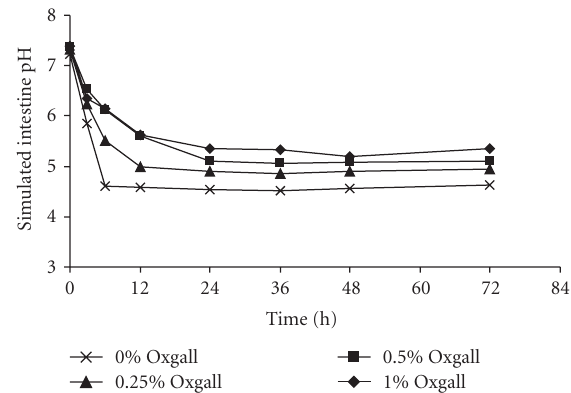
Figure 8: E ff ect of bile concentration on metabolic activity of mi- croencapsulated L. plantarum 80 BSH + and change in pH in simu- lated intestine. Triplicate samples were pooled prior to analysis.